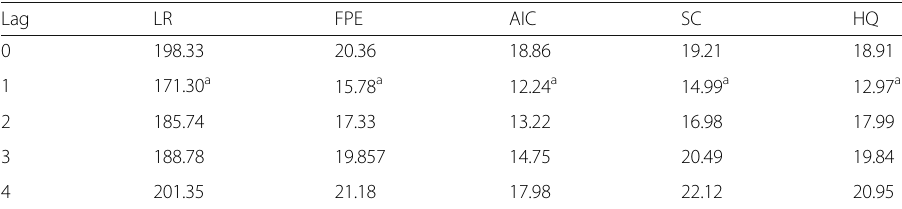
Table 4 Lag length Selection